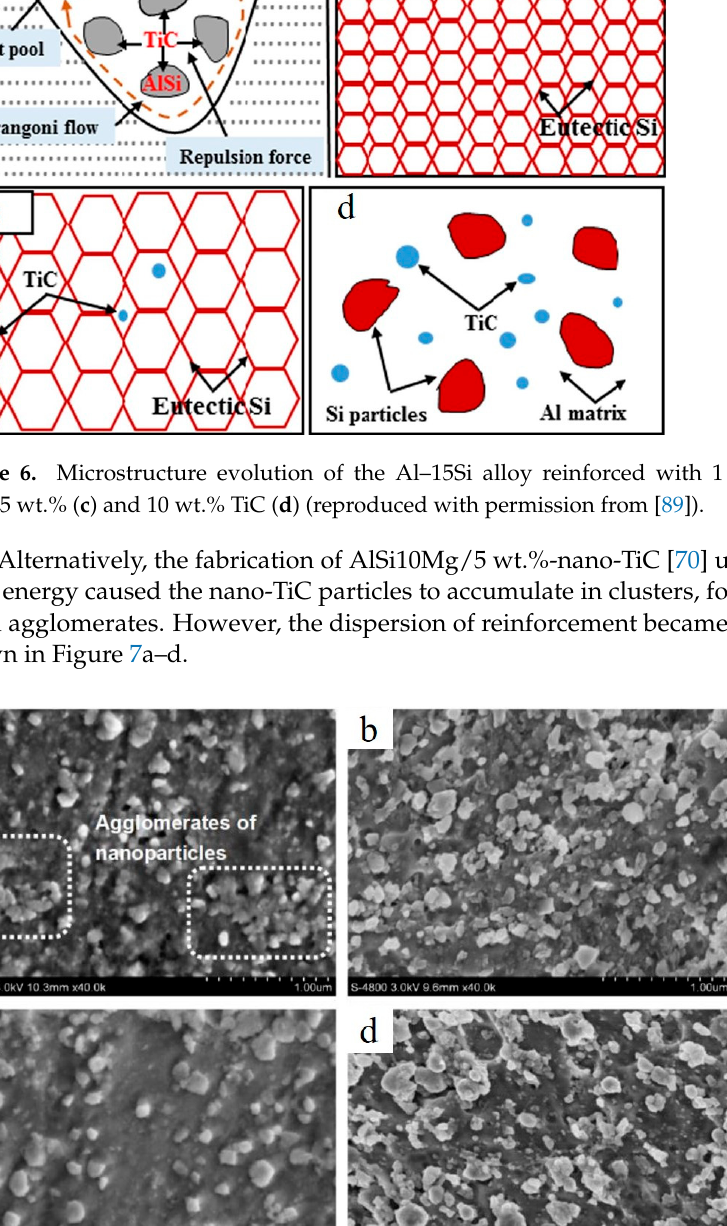
Figure 8. SEM images demonstrating the dispersion states of nano-TiC particles in LPBFed AlSi10Mg/3 wt.%TiC composites at E v = 160 J/mm 3 ( a ), E v = 200 J/mm 3 ( b ), E v = 240 J/mm 3 ( c ) and E v = 280 J/mm 3 ( d ) (reproduced with permission from [71]). The formation of ring-structured TiC was reported in Ref. [22] as well. At 5 and 7.5 wt.% TiC addition, at elevated Marangoni force and a lower viscous drag force, the ceramic particulates are captured in the circular melt motion (Figure 9b,c) and generate distinct circular structures in solidified build (Figure 9e–g). The circular-structured TiC agglomerate formation was not found in Ref. [70] when 5 wt.% TiC was used, which can probably be justified by the application of different process parameters.